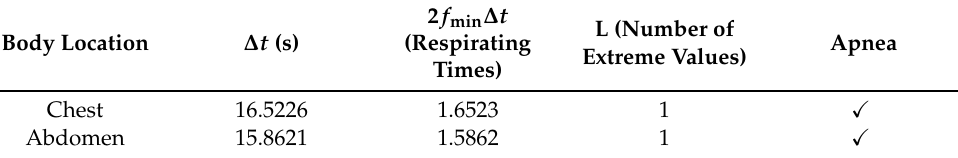
Figure 20. Apnea monitoring using Butterworth bandpass filtering. Table 4. Apnea monitoring results using Butterworth bandpass